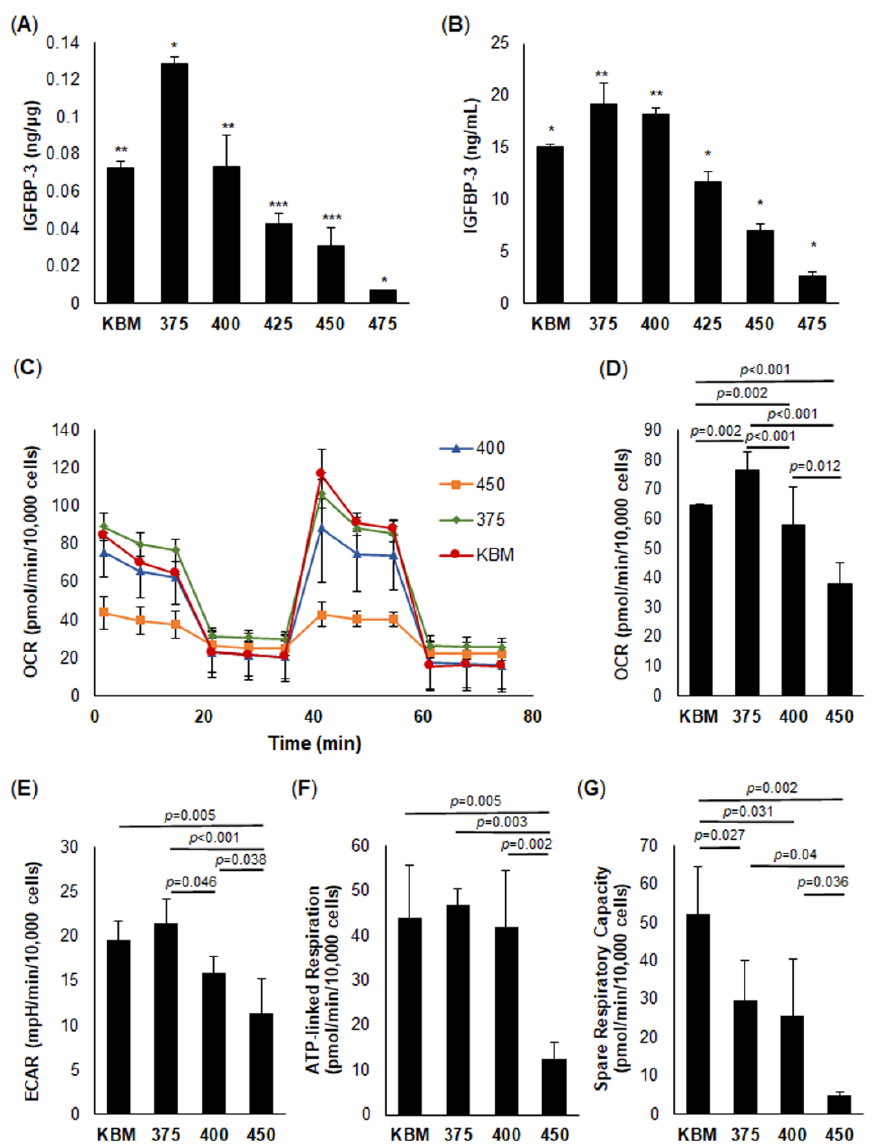
Figure 1. Insulin-like growth factor binding protein-3 (IGFBP-3) levels parallel changes in mitochon- drial respiration under increasing hyperosmolar stress. hTCEpi cells were treated with increasing osmolarity levels in keratinocyte basal media (KBM) for 24 h. Intra- and extracellular levels of IGFBP-3 were quantified using ELISA. ( A ) Intracellular IGFBP-3 expression was significantly increased in 375 mOsm, followed by a concentration-dependent decrease in IGFBP-3 (* p < 0.001, significantly different from all other groups; ** p < 0.001, *** p < 0.001 significantly different from all other groups except each other). ( B ) Extracellular levels of IGFBP-3 showed a similar trend (* p < 0.001, signif- icantly different from all other groups; ** p < 0.001, significantly different from all other groups except each other). ( C – G ) Seahorse metabolic flux analysis. ( C ) Oxygen consumption rate (OCR) plotted as a function of time. Arrows indicate timepoints at which oligomycin (O), FCCP ( F ), and rotenone/antimycin A (R/A) were added. ( D ) OCR was increased at 375 mOsm compared to control and sequentially decreased with increasing levels of salt. ( E ) Extracellular acidification rate (ECAR) was not significantly increased at 375 mOsm, but was decreased at higher osmolarity. ( F ) ATP-linked respiration decreased at the highest osmolarity tested (450 mOsm). ( F ) Spare respiratory capacity decreased in all conditions with increased osmolarity. Data are represented as mean ± standard deviation from a single experiment that was independently repeated three times, one-way ANOVA, and SNK multiple comparison